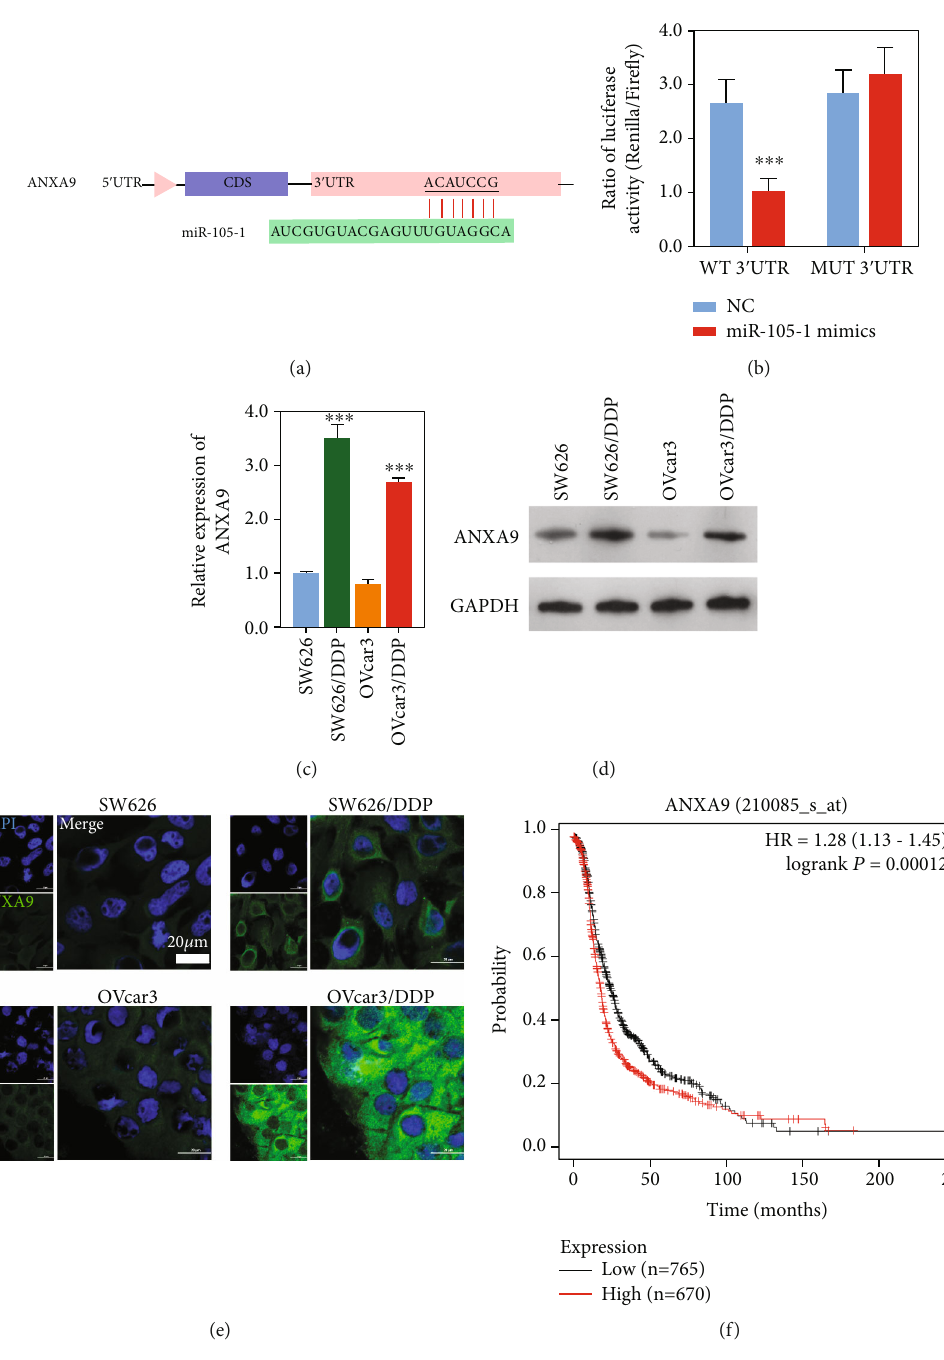
Figure 2: ANXA9 was a target gene of Hsa-miRNA-105-1 in OC cells. (a) Schematic diagram showing the complementary sequences in the 3 ′ untranslated region (UTR) of ANXA9 mRNA and seed sequence of Hsa-miRNA-105-1. (b) Luciferase activity ( fi re fl y luciferase normalized to Renilla luciferase) in cells transfected with the wild-type or mutant ANXA9 3 ′ -UTR reporter construct ( n = 3 , ∗∗∗ P < 0 : 01 , and paired t -test). (c) The levels of ANXA9 mRNA expression in parental and cisplatin-resistant OC cells ( n = 3 , ∗∗∗ P < 0 : 01 , and paired t -test). (d, e) The levels of ANXA9 protein expression in parental and cisplatin-resistant OC cells were detected by western blotting and immuno fl uorescence. Blue represents the cell nucleus stained with DAPI; green represents ANXA9 positive expression. (f) The e ff ect of ANXA9 expression level on an OC patient ’ s prognosis as indicated in the Kaplan-Meier Plotter